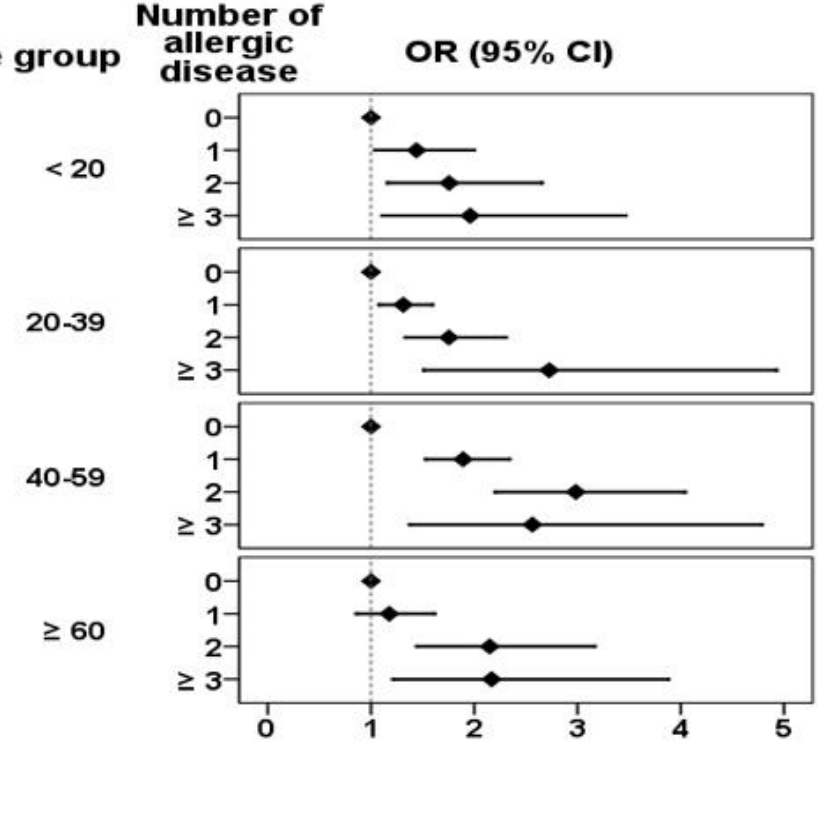
Figure 3. Logistic regression estimayed odds ratio of SLE by age and number of atopic